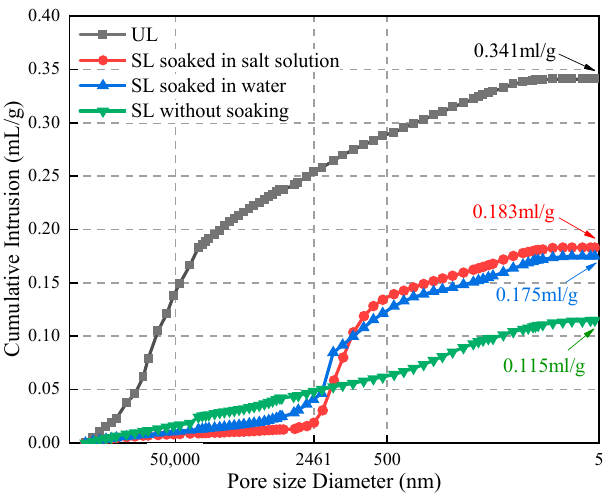
Figure 13. Cumulative intrusion.